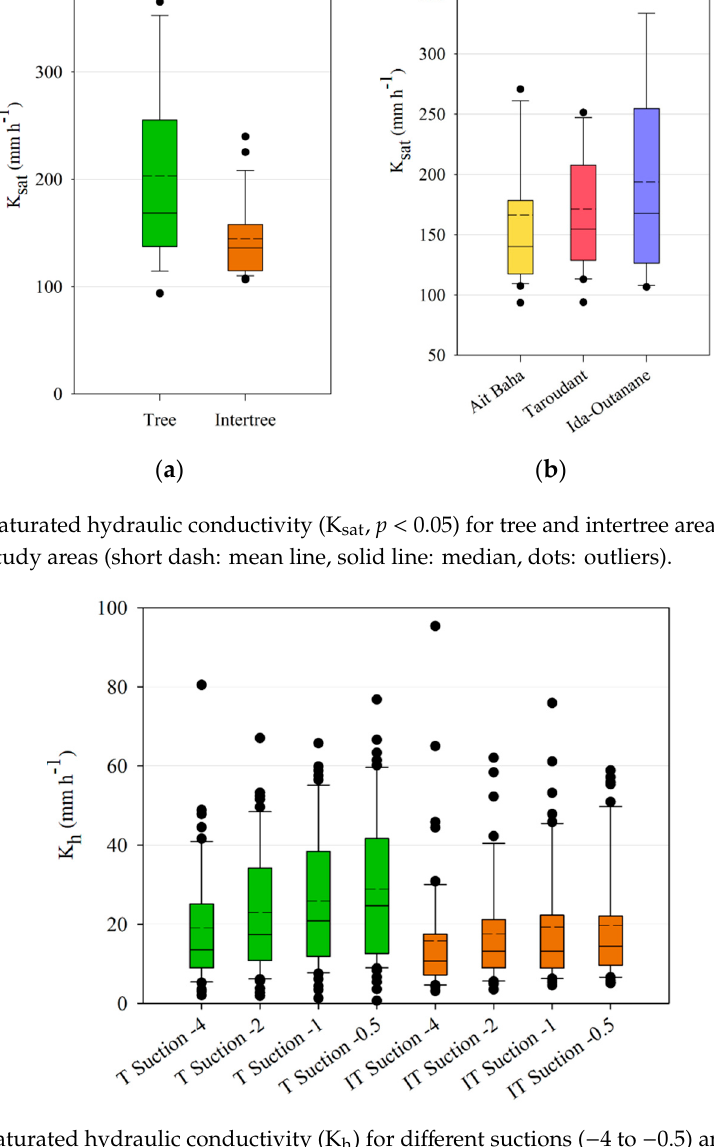
Figure 9. Unsaturated hydraulic conductivity (K h ) for different suctions ( − 4 to − 0.5) and tree (T) and intertree (IT) areas (short dash: mean line, solid line: median, dots: outliers).